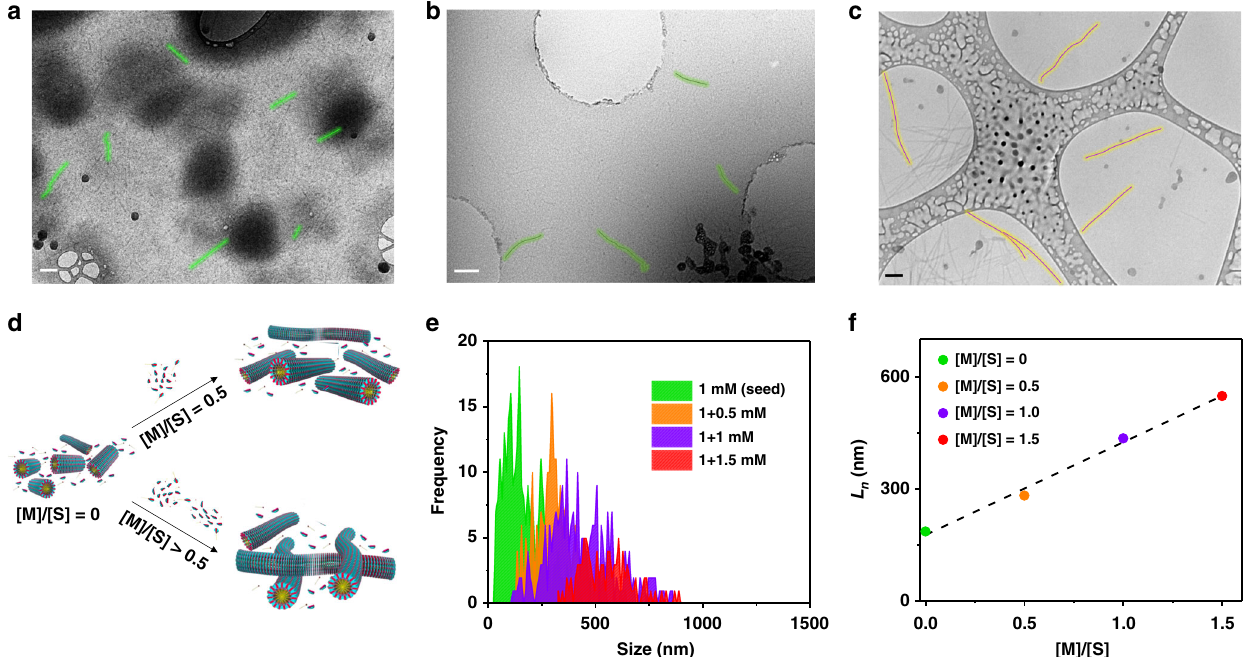
Fig. 3 Investigation of controlled growth by cryo-TEM. a – c Cryo-TEM images of 1.2-8A with varying amounts of monomer addition onto a seed. [ a seed (1 mM of 8A , [ 1.2 ] = 1 mM), b seed (1 mM of 8A ) + monomer (0.5 mM of 8A ) ([ 1.2 ] = 1.5 mM), c seed (1 mM of 8A ) + monomer (1.0 mM of 8A ) ([ 1.2 ] = 2 mM)]. d Schematic representation of seeded growth. e Frequency distribution of number average lengths ( L n ) obtained from the cryo-TEM images. f Linear trend between L n and monomer to seed ratio. Scale: a 100 nm, b 200 nm, c 100 nm. Green and brown overlays in a – c point out some